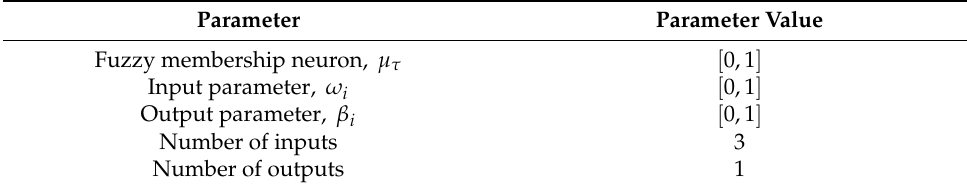
Table 2. Listing of related parameters in the 3SATFuzzy.